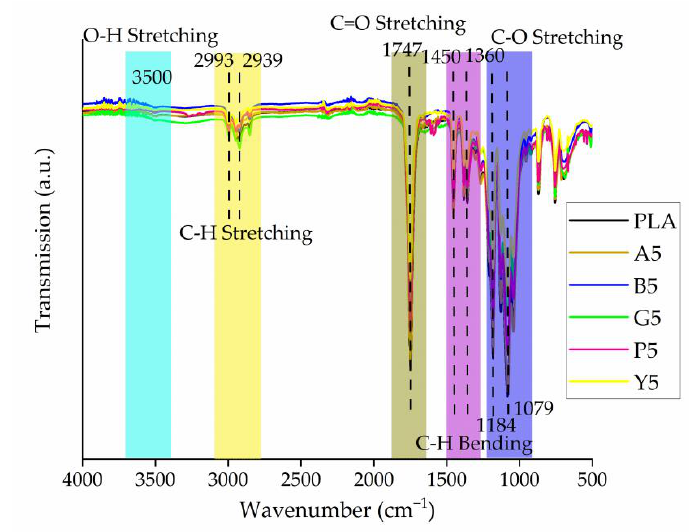
Figure 6. FTIR spectra of PLA and its master batches containing 5% ( w / w ) of each colorant.